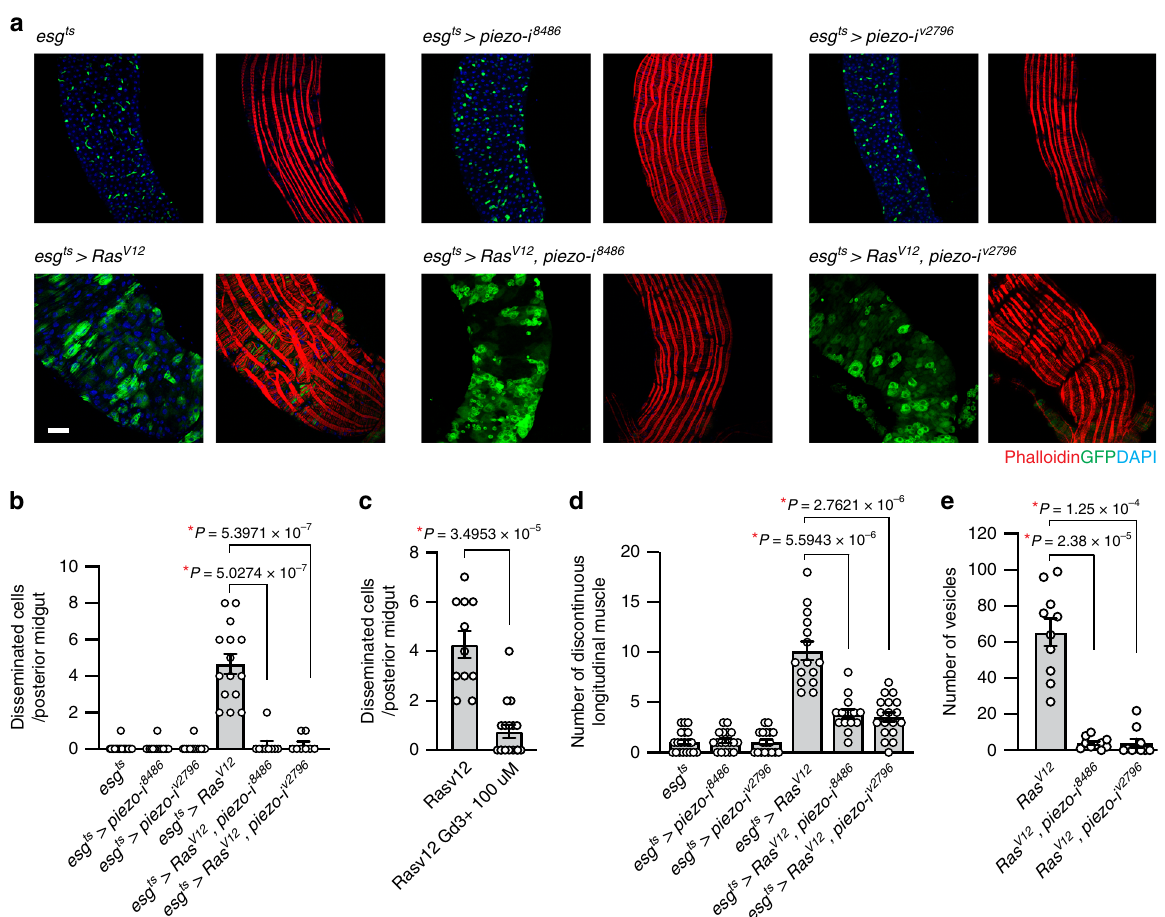
Fig. 5 The mechanosensory channel Piezo is required for dissemination of Ras V12 cells. a Representative images of posterior midguts. Transgenes were induced for 2 days with esg ts . Scale bar, 50 µ m. b Quanti fi cation of disseminated cells residing on the surface of VM. N = 20 ( esg ts ), N = 15 ( esg ts > piezo- i 8488 ), N = 14 ( esg ts > piezo-i v2796 ), N = 15 ( esg ts > Ras V12 ), N = 9 ( esg ts > Ras V12 , piezo-i 8488 ), N = 8 ( esg ts > Ras V12 , piezo-i v2796 ) biological replicates. c Quanti fi cation of disseminated cells detected on the surface of VM. 100 µ M GdCl 3 -supplemented food was fed for 2 days while expressing Ras V12 with esg ts . N = 11 ( esg ts > Ras V12 ), N = 17 ( esg ts > Ras V12 ) biological replicates. d Quanti fi cation of discontinuous longitudinal muscles. N = 21 ( esg ts ), N = 18 ( esg ts > piezo-i 8488 ), N = 18 ( esg ts > piezo-i v2796 ), N = 15 ( esg ts > Ras V12 ), N = 14 ( esg ts > Ras V12 , piezo-i 8488 ), N = 18 ( esg ts > Ras V12 , piezo-i v2796 ) biological replicates. e Quanti fi cation of vesicles. N = 10 biological replicates for each genotype. In ( b – e ), mean ± SEMs are shown with individual data points. Data were analyzed by two-tailed unpaired Student ’ s t -test, asterisks indicate statistical signi fi cance (* P < 0.01), and P values are indicated in